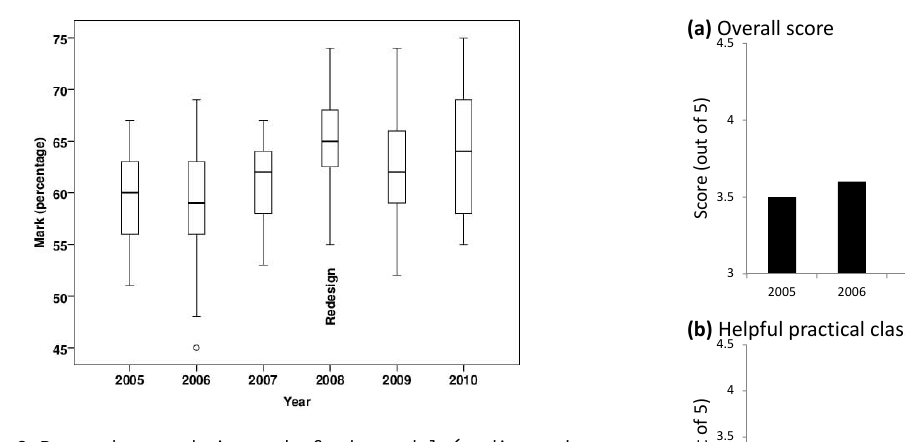
Fig. 3. Pre- and post-redesign marks for the module (median mark indicated by horizontal line, inter-quartile range indicated by box).